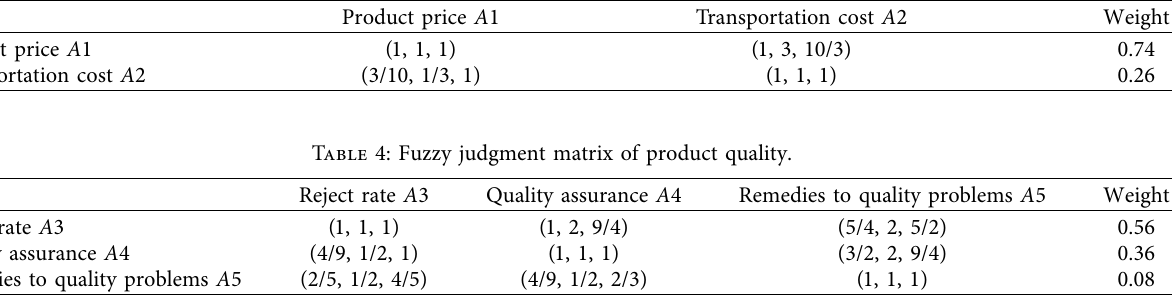
Table 3: Fuzzy judgment matrix of product cost.